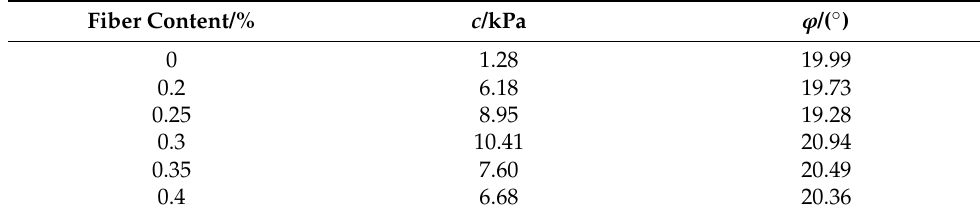
Table 2. Shear strength index of samples.